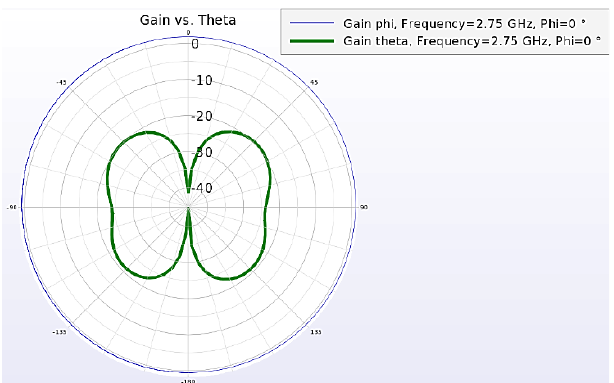
FIGURE 5. Simulated Gain Plots for 2.75